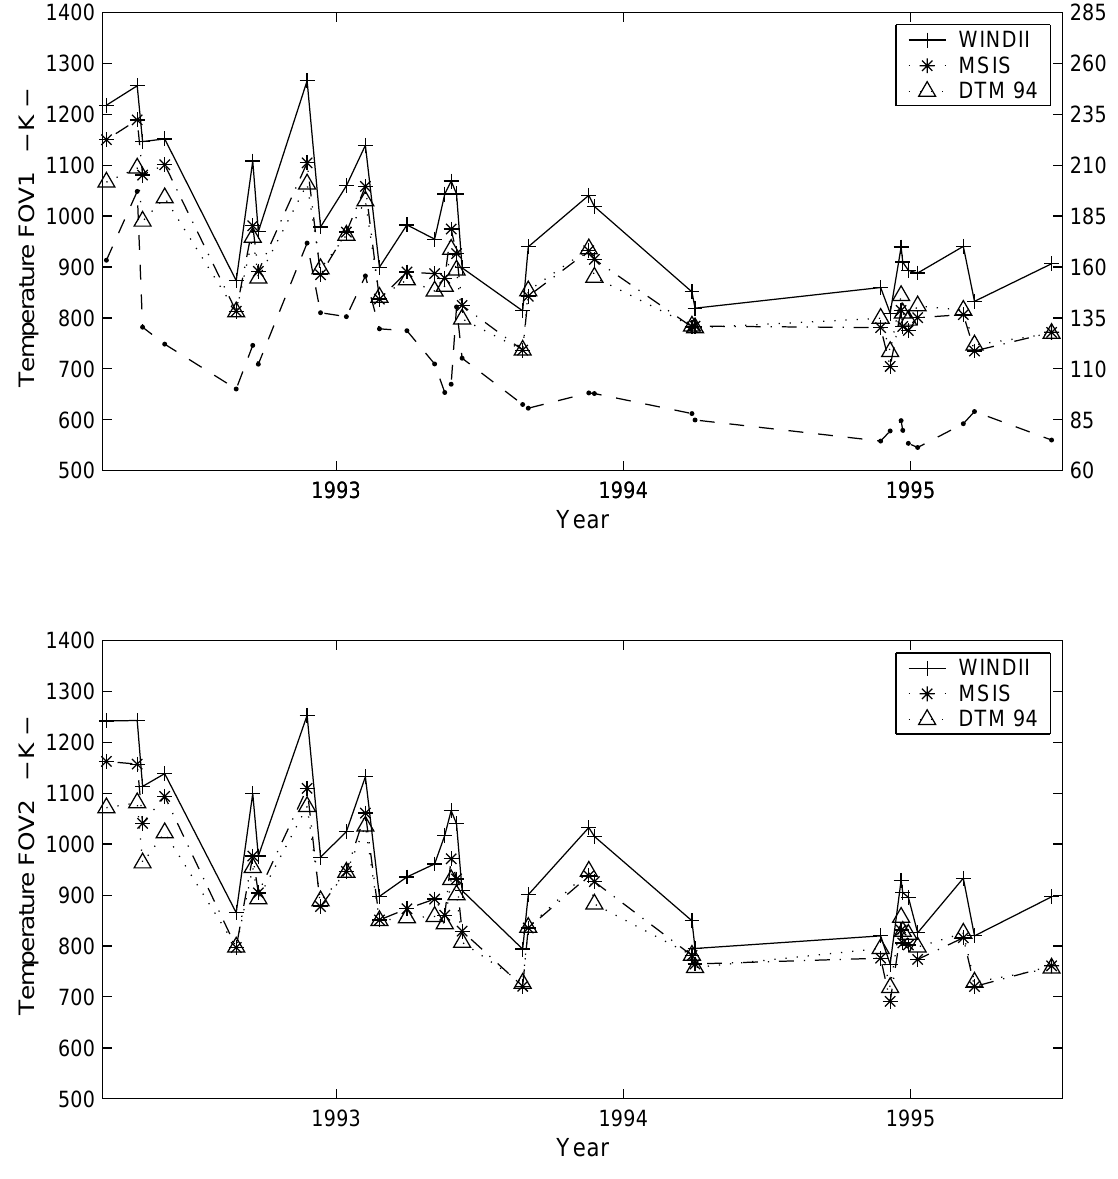
Fig. 6. Mean temperatures averaged over the altitude range of 180 to 260km for 33 quiet days. The upper and lower panels correspond, respectively, to FOV 1 and 2. WINDII data are plotted with the continuous line, while the temperatures obtained from the MSIS-90 and DTM-94 models are, respectively, plotted with the dash-dotted and the dotted lines. The F10.7cm index (of the previous day) is shown as a dashed line in the upper panel. The corresponding scale is on the right side of the